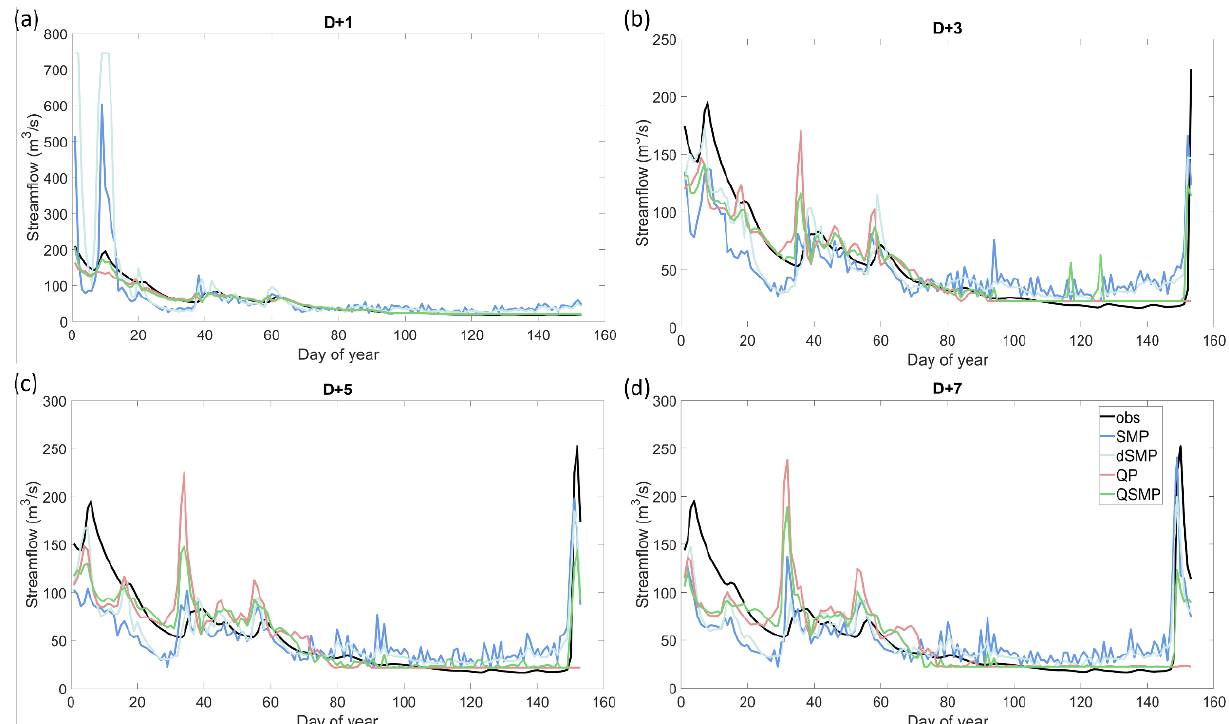
Figure 11. Hydrographs for the Androscoggin watershed for summer 2010 (validation period) ( a ) 1, ( b ) 3, ( c ) 5 and ( d ) 7 days in advance.